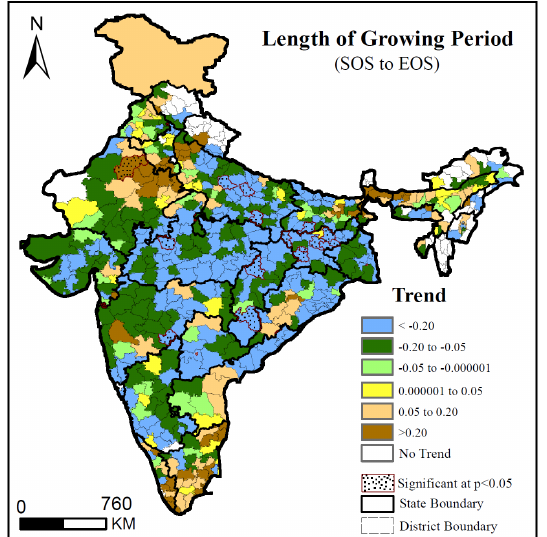
Figure 11 Trends of length of growing period for Kharif crop during 1982-2015.